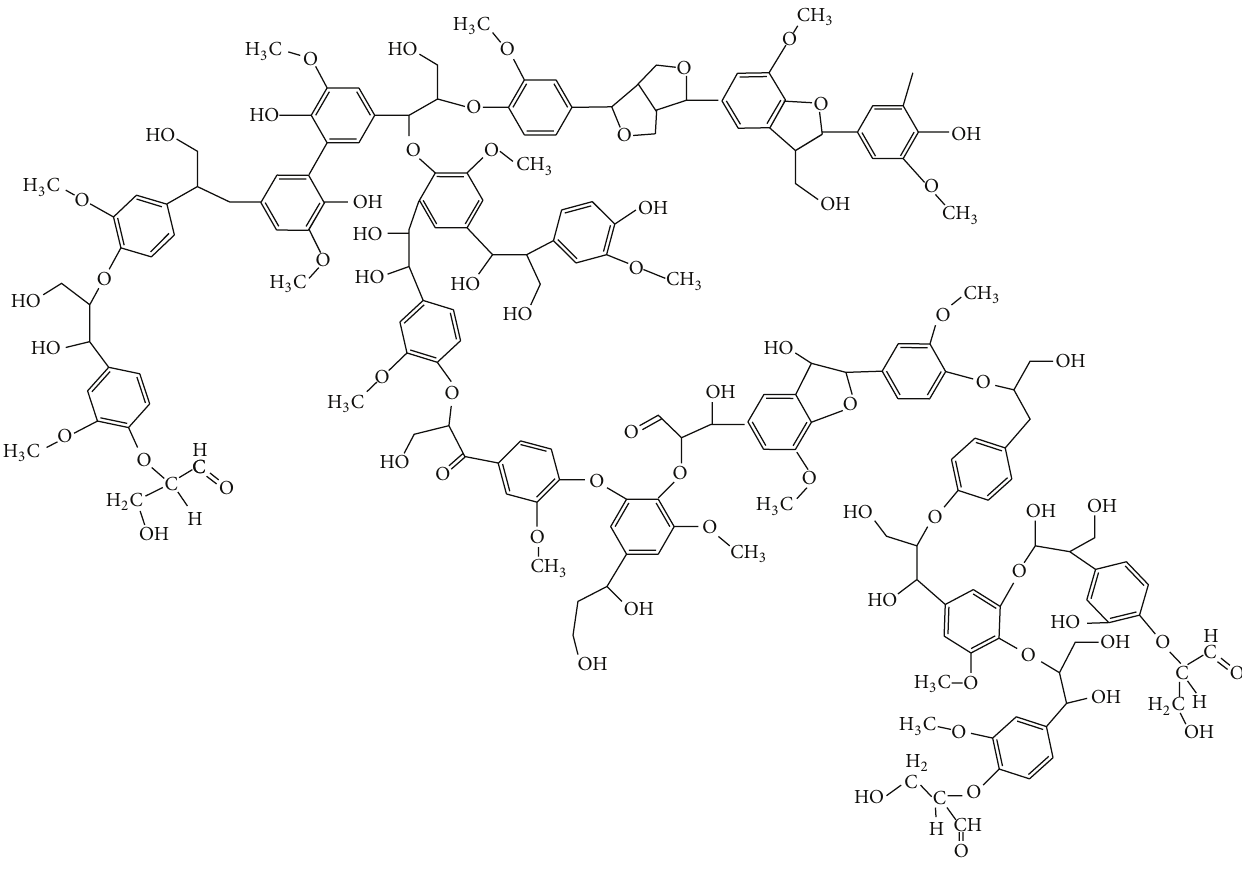
Figure 1: Structure of lignin